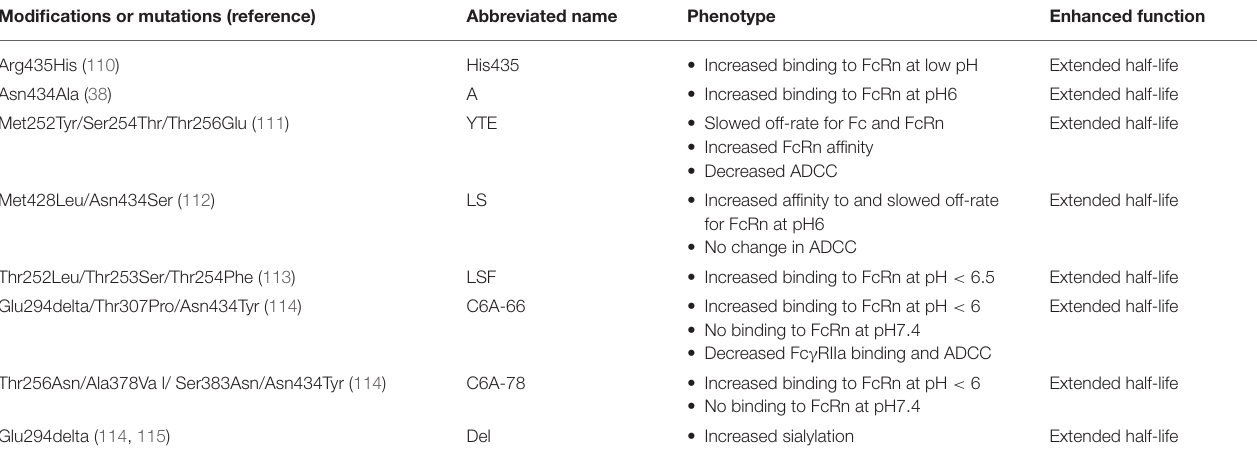
TABLE 2 | Fc modifications to improve antibody circulation